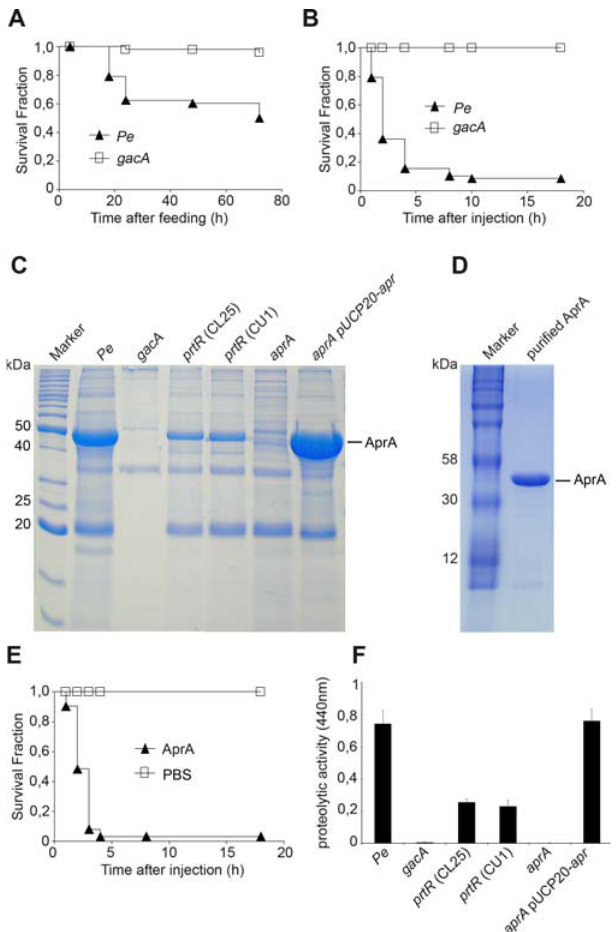
Figure 1. Identification and Regulation of a P. entomophila Protease (A) Survival analysis of wild-type (Or R ) larvae following feeding with 60- fold concentrated sterile filtered culture supernatants of wild-type P. entomophila and its gacA mutant. Survival analysis was repeated three times and performed on 50 larvae. Log-rank analysis demonstrated a statistically significant difference in survival of flies fed with supernatant from wild-type P. entomophila and flies fed with supernatant from the gacA mutant ( p , 0.0001). (B) Survival analysis of wild-type (Or R ) adult flies ( n ¼ 60) injected with 69 nl of non-concentrated supernatants of wild-type P. entomophila and its gacA mutant. Log-rank analysis demonstrated a statistically significant difference in survival of flies injected with supernatant from wild-type P. entomophila and flies injected with supernatant from the gacA mutant ( p , 0.0001). (C) SDS-PAGE analysis of culture supernatants from P. entomophila derivatives. Protein extracts from culture supernatants (OD 600 ¼ 2) following growth at 29 8 C for 24 h, were loaded and stained with Coomassie blue. The genotypes of the bacterial strains used are indicated on the top. The first lane represents the molecular weight marker (indicated in kDa on the left). CL25 and CU1 are two independent Tn 5 insertions in the prtR locus [10].The last lane displays the aprA mutant complemented with a plasmid expressing the aprA locus. AprA corresponds to the major band at 51 kDa. (D) Purification of P. entomophila AprA. Lane 1, molecular weight marker. Lane 2, purified peak fraction of AprA. (E) Survival analysis of wild-type adult flies ( n ¼ 60) following microinjection of 9.2 nl of purified AprA protease (50 l g/ml) or PBS. Flies succumbed within 4 hr after microinjection of pure protease. Log- rank analysis demonstrated a statistically significant difference in survival of flies injected with AprA and flies injected with PBS ( p , 0.0001). (F) Proteolytic activity of supernatant of P. entomophila derivatives as measured at 440 nm by the azocasein test. DOI: